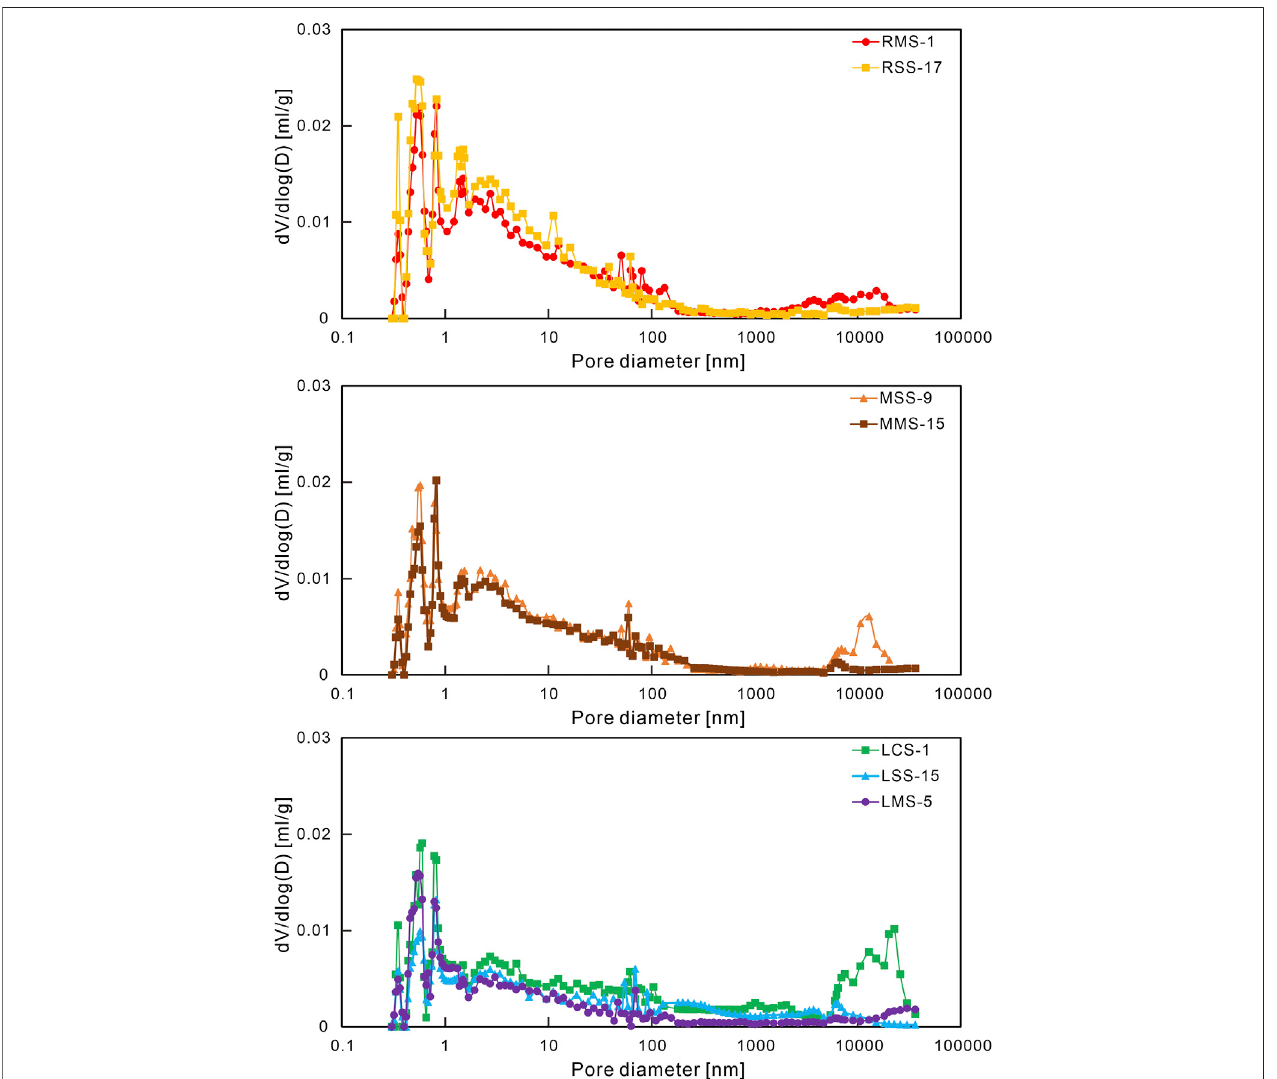
FIGURE 8 | Pore size distribution of different lithofacies samples derived from the combination of CO 2 GA, N 2 GA and HPMI experiments.